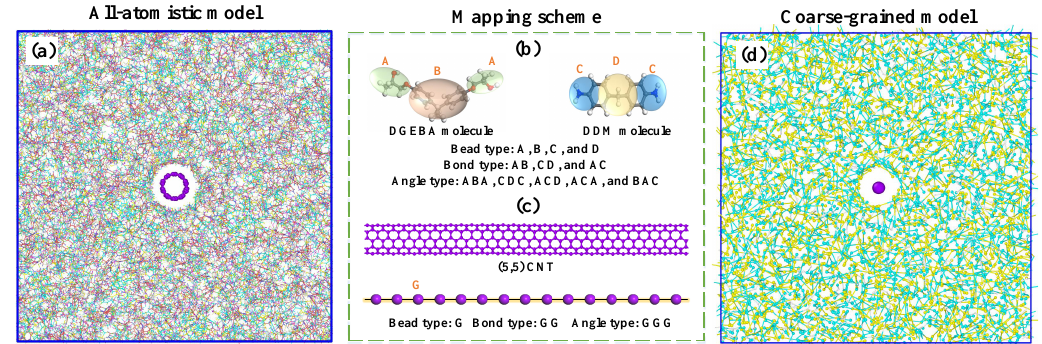
Figure 1. Schematic view of mapping all-atomistic model to coarse-grained model for epoxy nanocomposites reinforced by (5,5) carbon nanotube (CNT). ( a ) Snapshot of the all-atomistic model, ( b ) the adopted mapping scheme for DGEBA and DDM molecules, ( c ) the adopted mapping scheme for (5,5) CNT, and ( d ) snapshot of the resulting coarse-grained